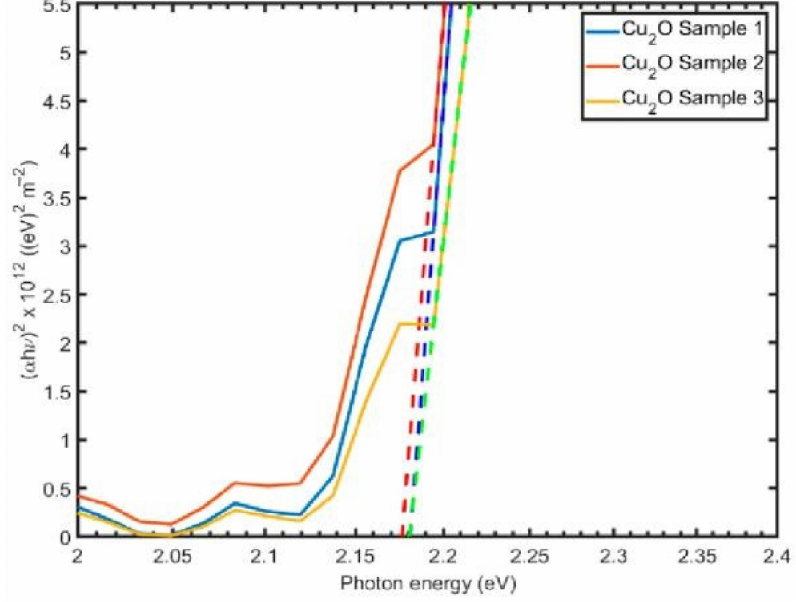
Figure 20. Tauc plots of Samples 1, 2, and 3 deposited on quartz substrate